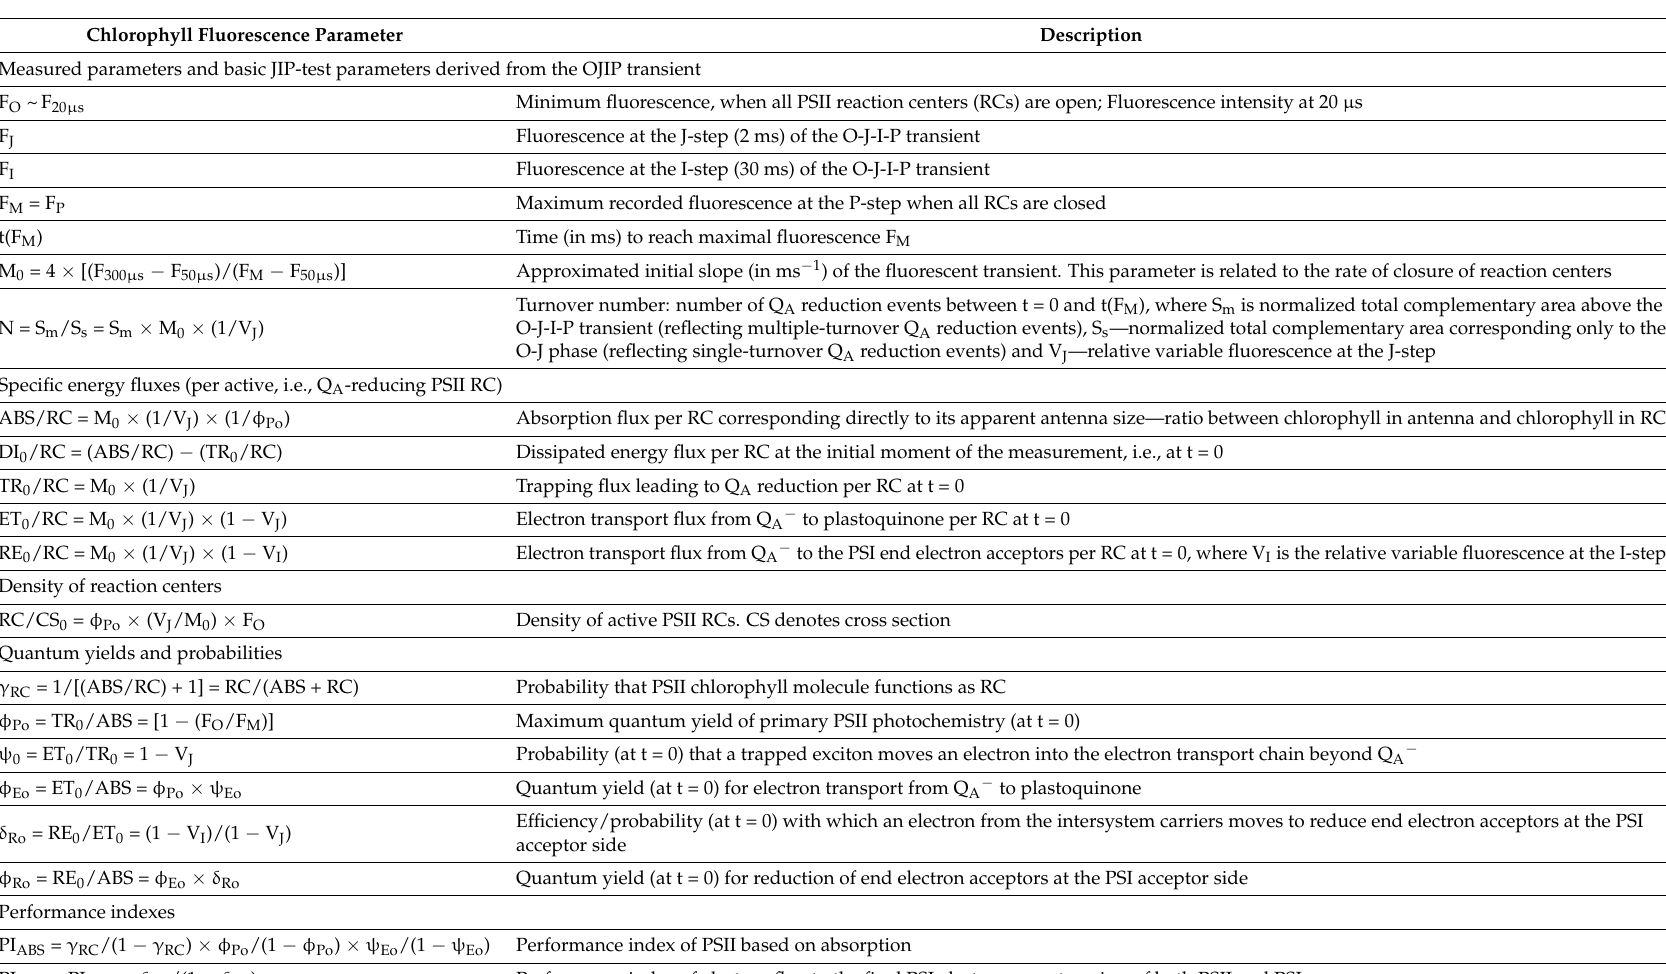
Table 3. Definitions of measured and calculated chlorophyll a fluorescence parameters used in the experiment (Based on [49,55,56,58,67]). Chlorophyll Fluorescence